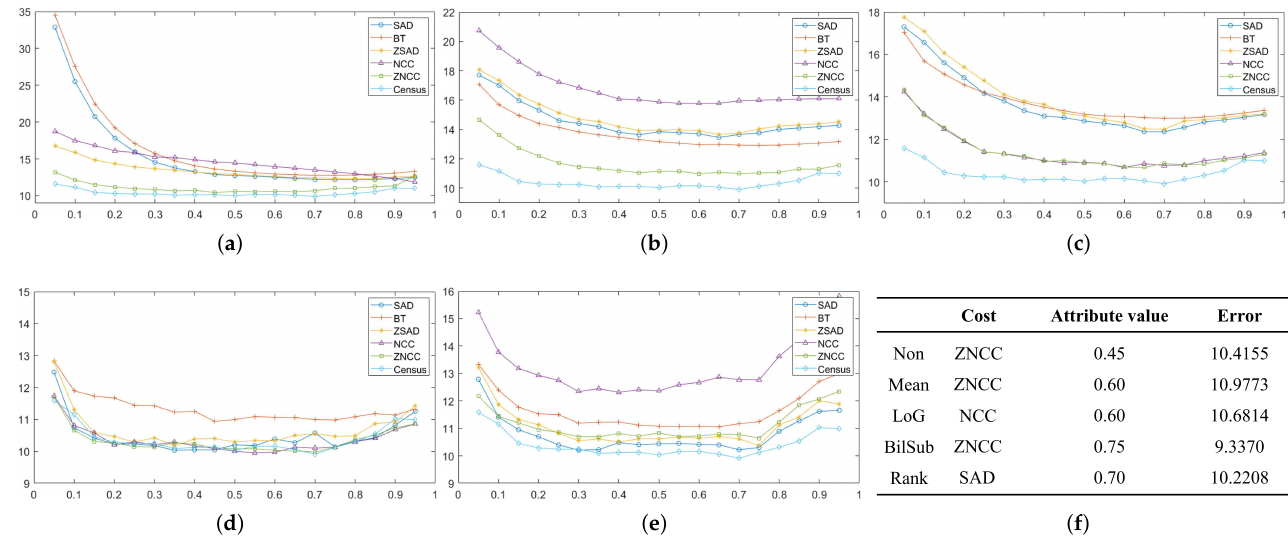
Figure 12. Errors of combinations of cost and image filter using the window-based stereo method, according to the variation of the pattern contrast parameter. ( a ) Non-filter. ( b ) Mean. ( c ) LoG. ( d ) BilSub. ( e ) Rank. ( f ) Best of Window